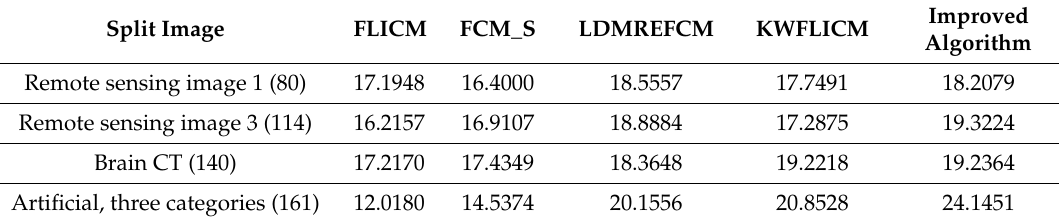
Figure 13. Multiplicative noise interfering with three types of artificial images ( a ) and the segmentation results ( b – f ). Table 7. Comparison of the PSNR (dB) for the multiplicative noise resistance of algorithms.